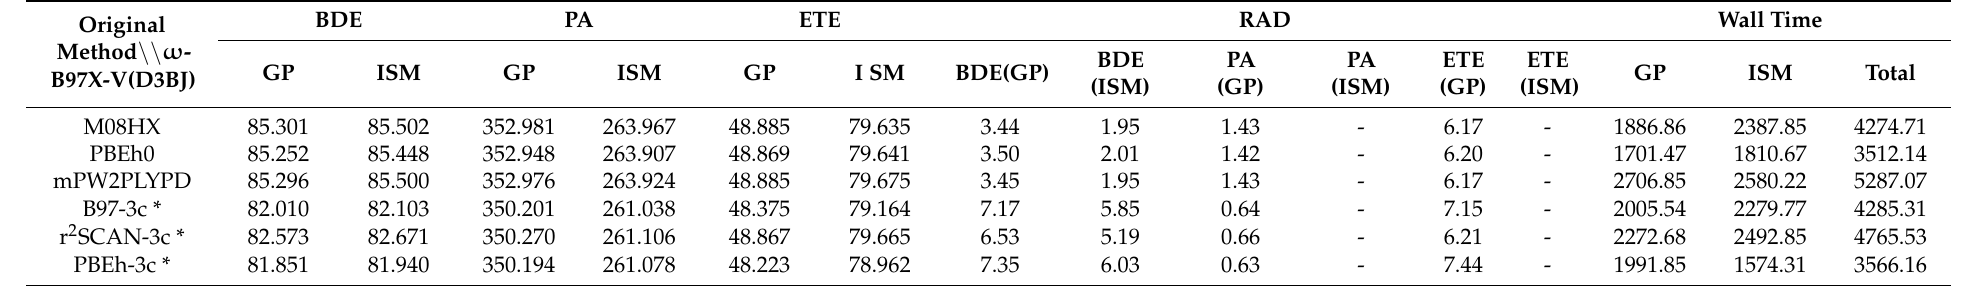
Table 4. The BDEs, PAs, and ETEs (kcal/mol), their respective estimated RADs (%), and the total wall times (s) performed using the original method/pcseg-1 \\ ω